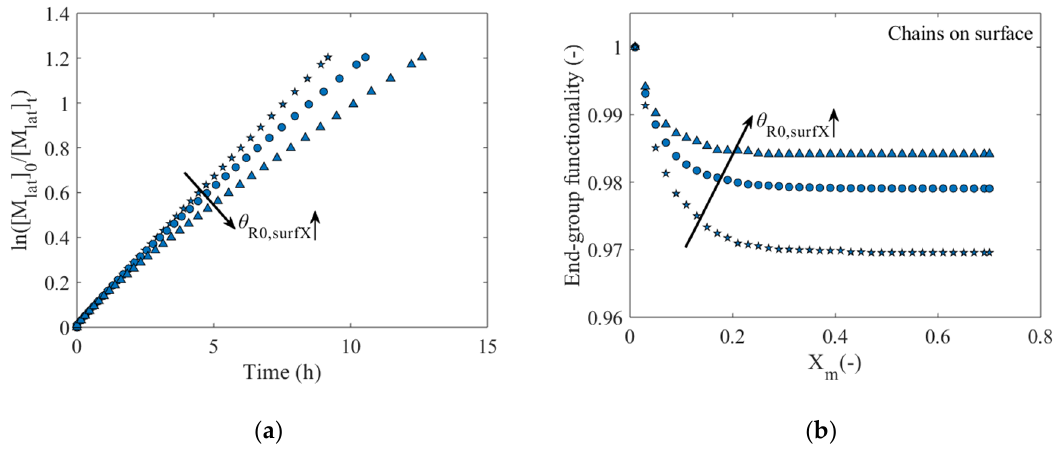
on the evolution of ln ( [ M R 0 ,sur (cid:3025)